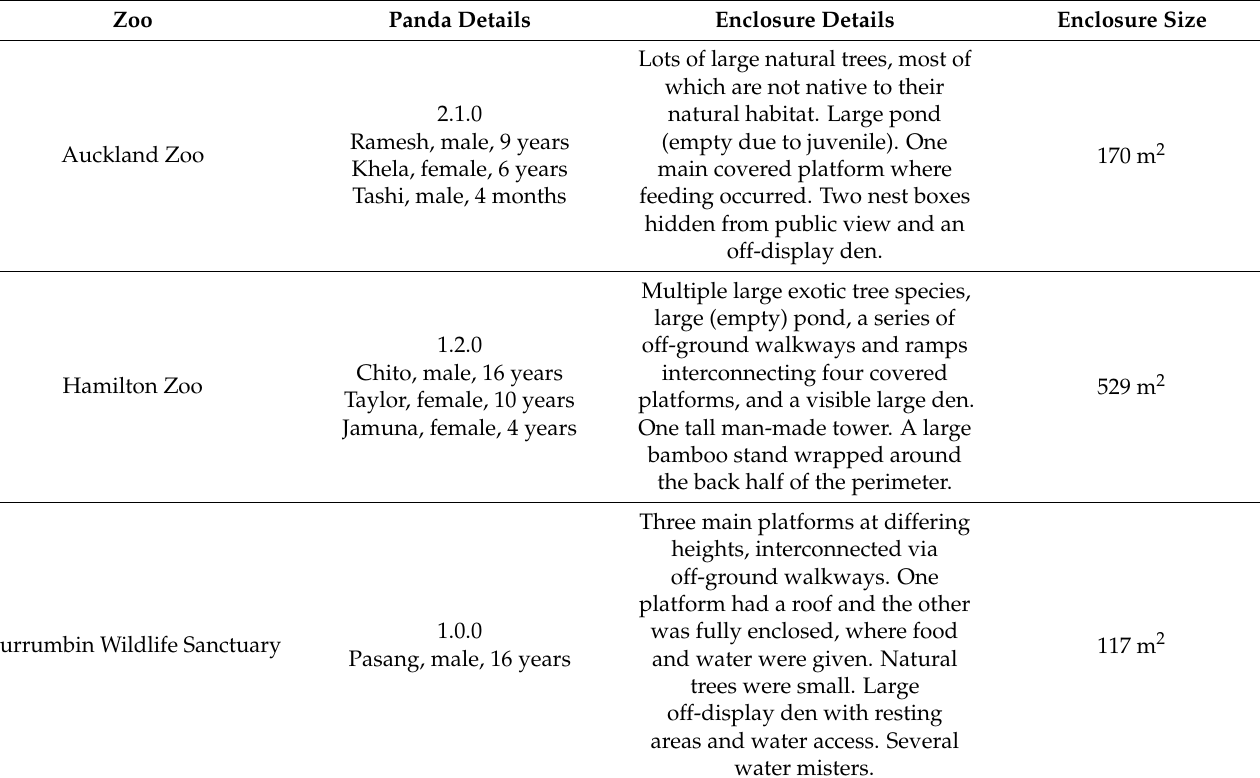
Table 1. Details of red panda studied and the enclosures they lived